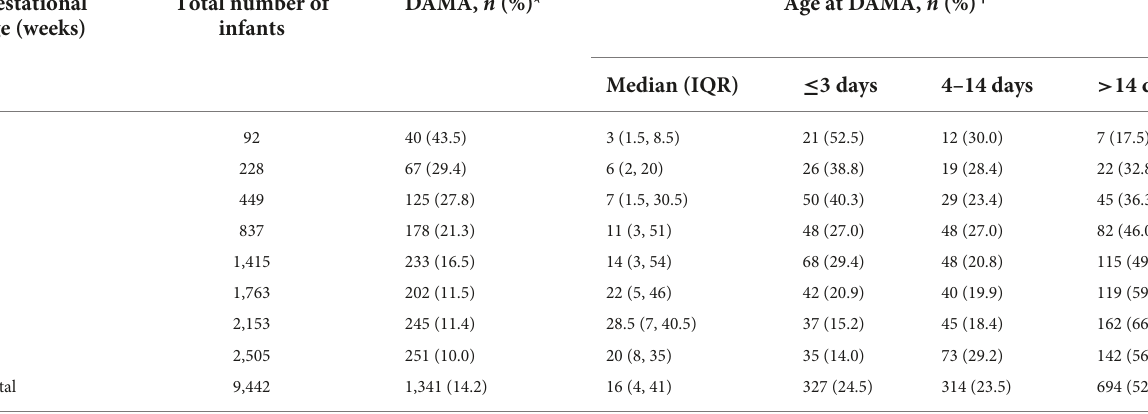
at the GA of 24 weeks, while there were still 10.0% of infants born at 31 weeks discharged against medical